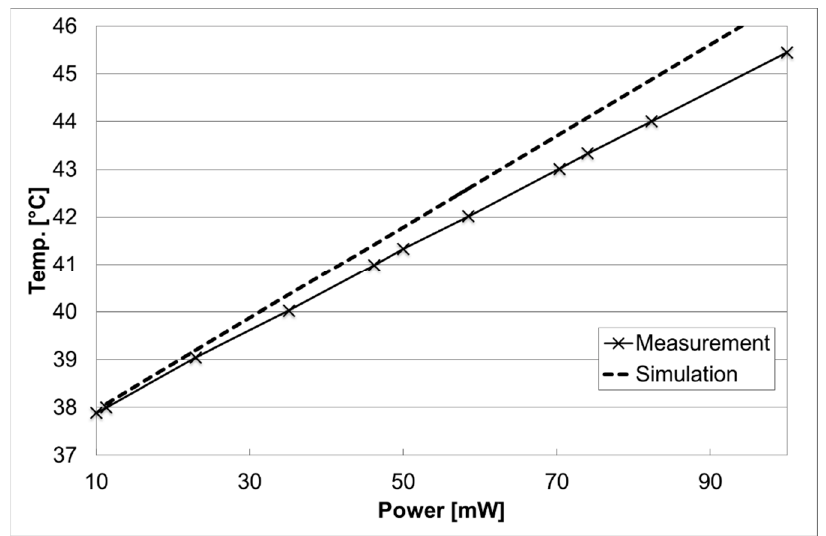
Figure 9. Characteristics of the temperature on the electrodes of the capacitor depending on the power of the microheater in the range of 10–100 mW for the measured values and the values from the simulation of the system.